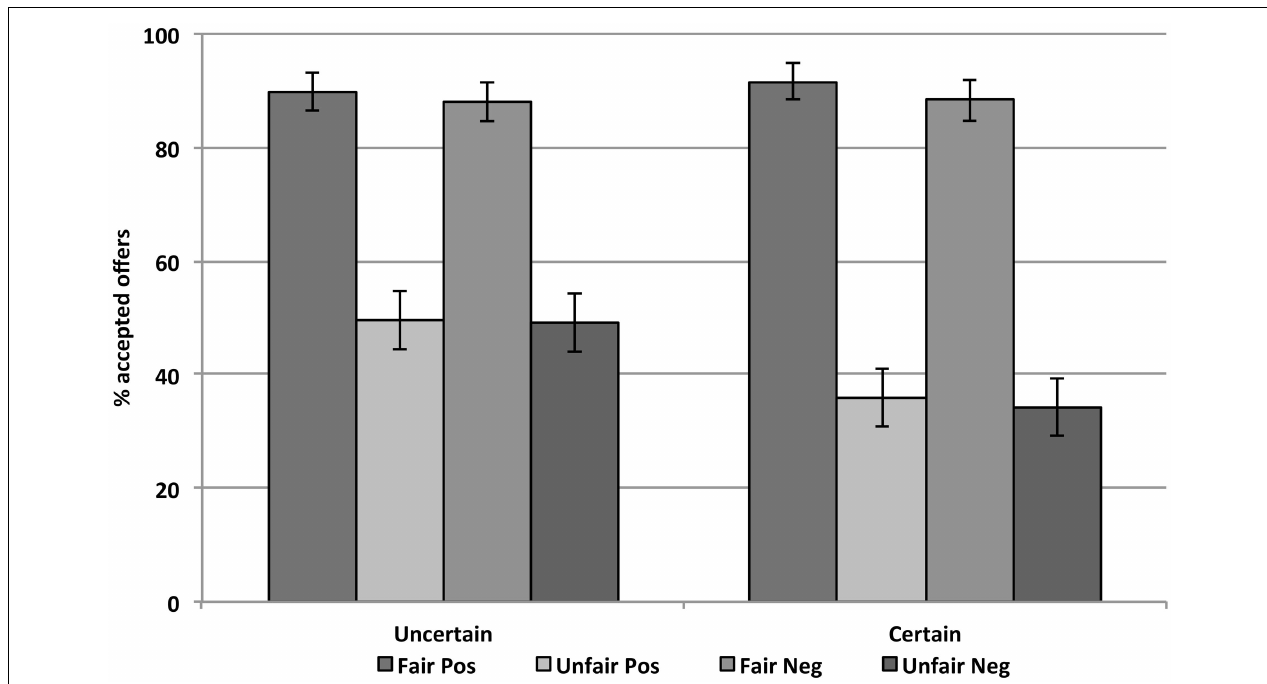
FIGURE 3 |Acceptance rates of fair and unfair offers preceded by positive and negative words in the uncertain and certain condition (Experiment 2). Error bars represent standard errors of the mean.